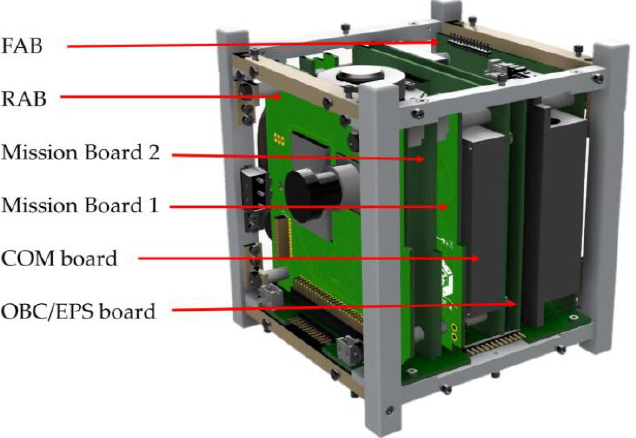
Figure 1. Bus system configuration.